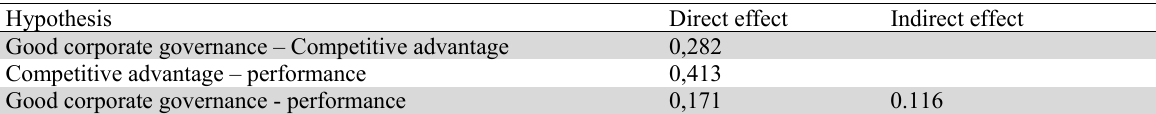
Direct and indirect effects Hypothesis Direct effect Good corporate governance – Competitive